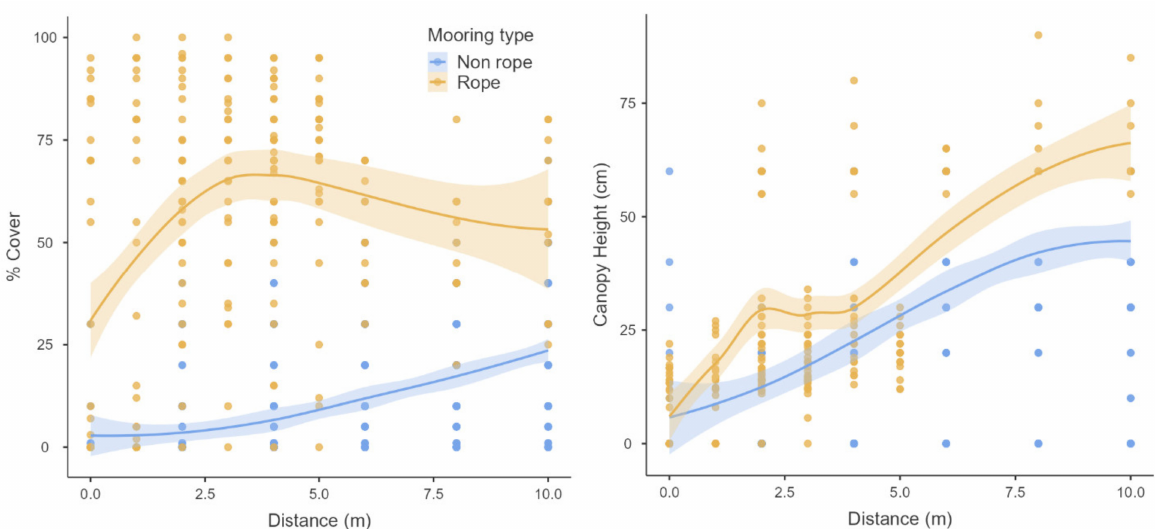
Figure 2. Seagrass % cover ( left ) and canopy height ( right ) with increasing distance from the base point of established boat moorings made from chain or rope (data combined across moorings in Porthdinllaen, north Wales, and southeast England, all sites are Zostera marina ). The data exclude those from Puerto Rico as there are no comparable chain mooring data. A quadratic smoothed regression line is shown ± its standard error. Data were collected at the four cardinal points of the compass around the